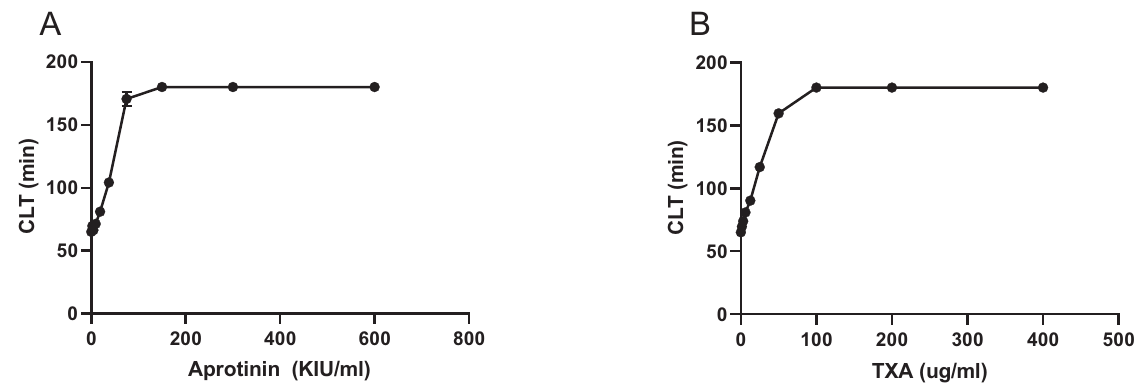
Fig. 1 The anti fi brinolytic effect of aprotinin and tranexamic acid (TXA). Aprotinin or TXA were added to pooled normal plasma in increasing concentrations and clot lysis times were determined. Shown are mean values of 3 independent experiments. Error bars indicate standard deviations (but are not visible for the majority of data points as standard deviations were very low).